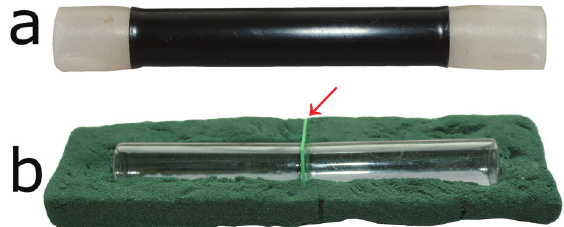
Figure 2. Tubes used for a boldness and b aggression tests. Arrow indicates the flap which was removed at the beginning of the